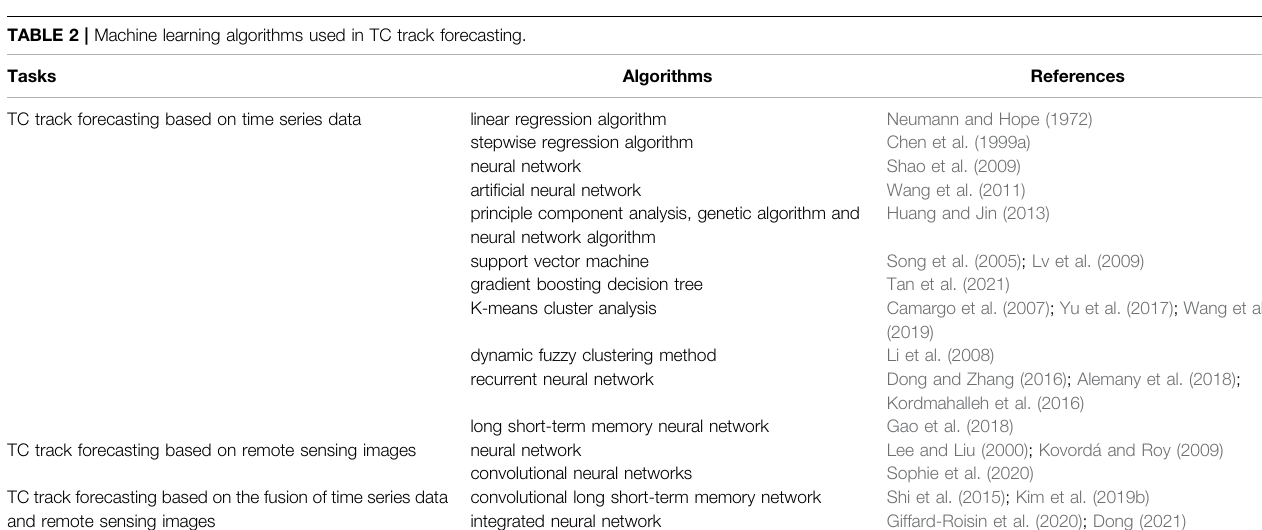
basis function (RBF) and generalized regression neural network algorithm to predict the seasonal TC activities over the North Indian Ocean. The results showed that all three algorithms performed well, and the performance of the multilayer perceptron model is better than that of the RBF and the generalized regression neural network model.